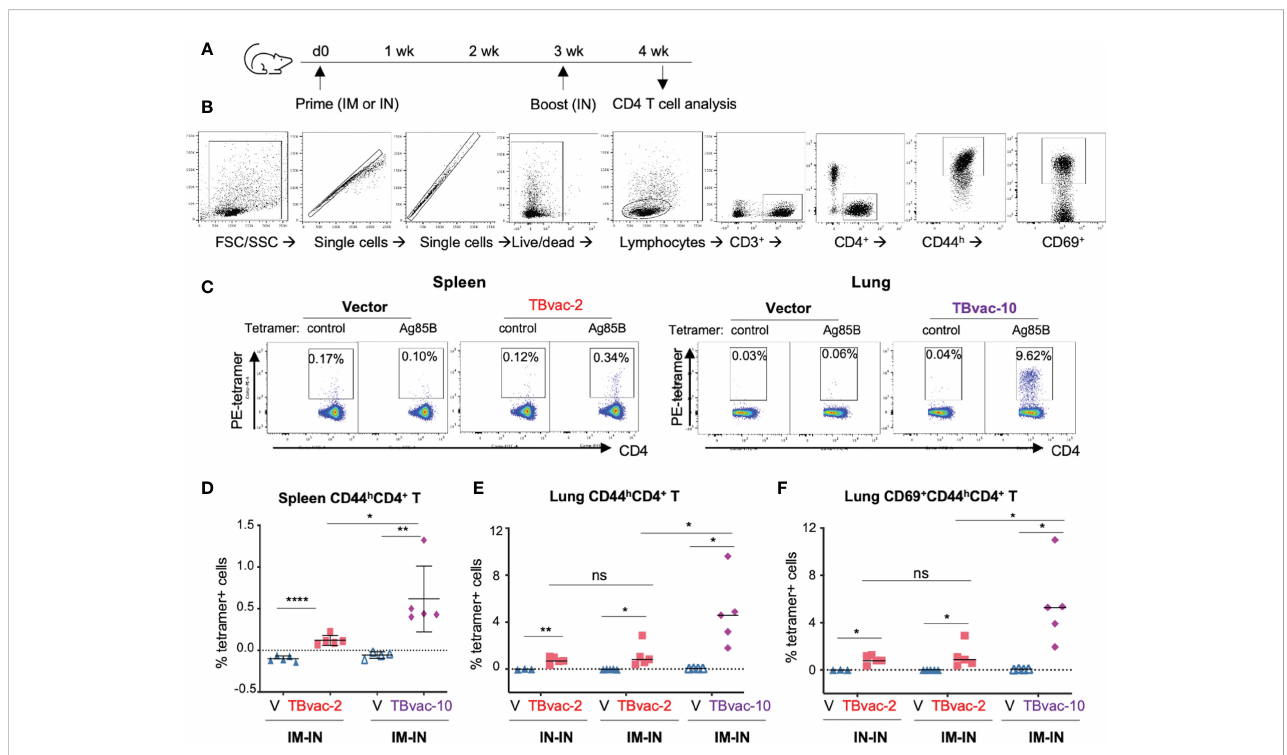
FIGURE 4 rP18tri-based TB vaccines induced strong antigen-speci fi c CD4 T cells. (A) BL6 mice (N=5) were immunized with rP18tri vector (V), TBvac-2, and TBvac- 10 through IM-IN or IN-IN prime-boost strategy. At 7 dpb, lymphocytes isolated from spleens or lungs were incubated with a PE-labeled control or Ag85B MHC-II tetramer, together with antibodies against cell surface markers (CD3, CD4, CD8, CD44, CD69). (B) Gating strategy used to analyze the MHC-II tetramer-positive CD44 high (CD44 h ) CD4 + T cells and lung CD69 + CD44 h CD4 + T cells. (C) Representative fl ow cytometry plots of control- and Ag85b-tetramer-positive CD44 h CD4 + T cells were shown for splenocytes of vector and TBvac-2 immunization, and for lung lymphocytes in vector and TBvac-10 immunization. After normalization with the control MHC-II tetramer, the Ag85B tetramer-positive spleen CD44 h CD4 + T cells (D) ,